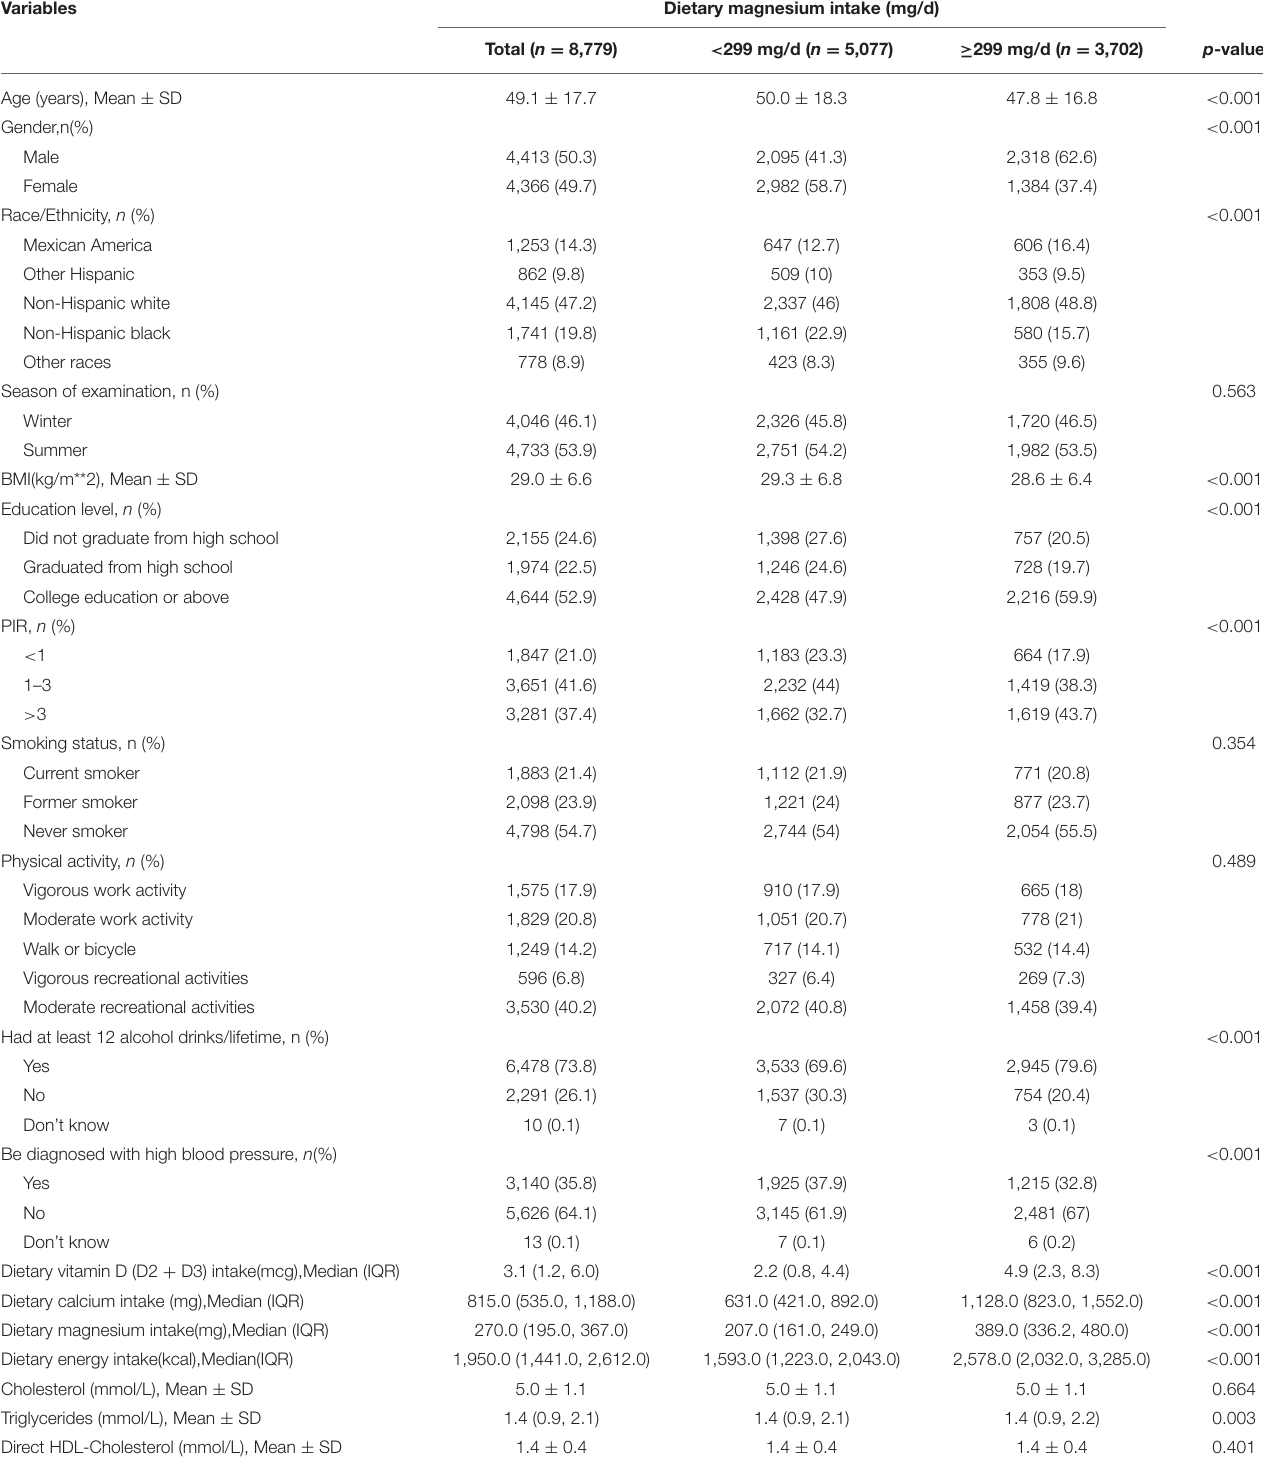
TABLE 1 | Characteristics of